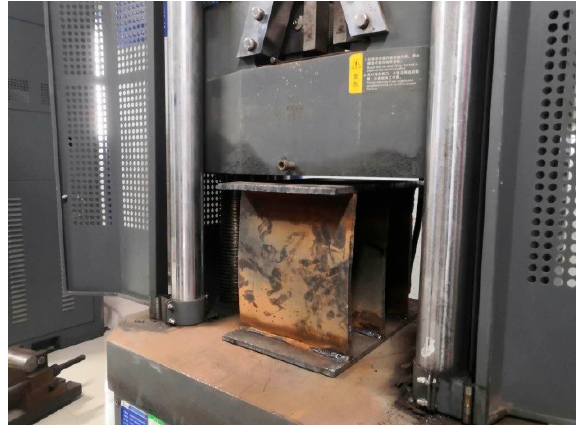
Figure 5. Compression testing machine.